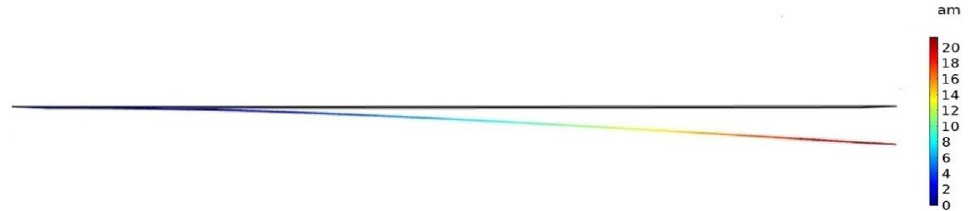
Figure 7. Deformation in a simulated profile for a silicon microcantilever with a width, length, and thickness of 20 µ m, 40 µ m, and 0.5 µ m, respectively. Maximum deflection of about 21 am is obtained in the unclamped free end of the suspended beam, when the microcantilever has a 500 nm cavity height while biased with 3 V DC.